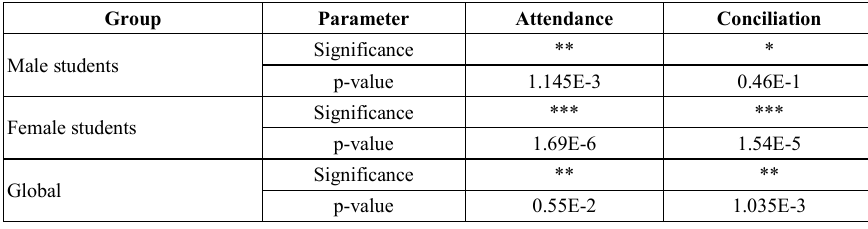
Table 5. Academic performance comparison: gender gap evolution (2019-2020)